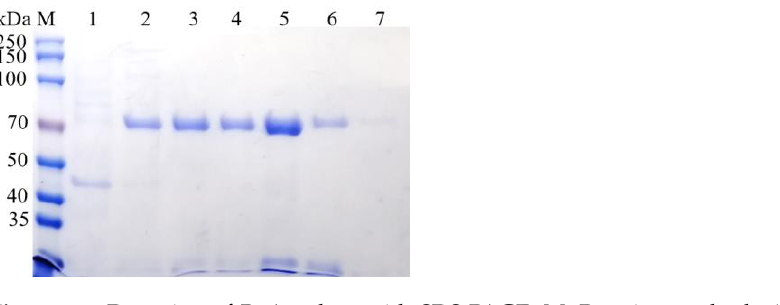
Figure 10. Detection of BvAmylase with SDS-PAGE. M: Protein standard. 1 – 7: The imidazole con- centration is 1: 50, 2: 100, 3: 100, 4: 100, 5: 200, 6: 200, 7: 300 mM/L. concentration is 1: 50, 2: 100, 3: 100, 4: 100, 5: 200, 6: 200, 7: 300